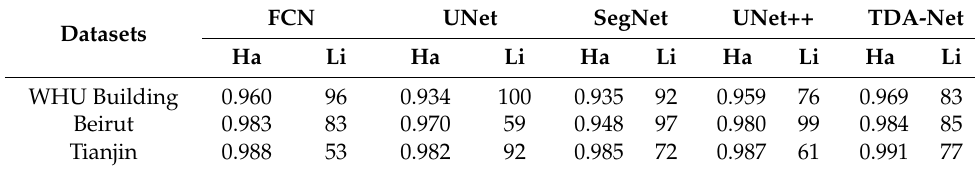
Table 3. Model details of the training process.